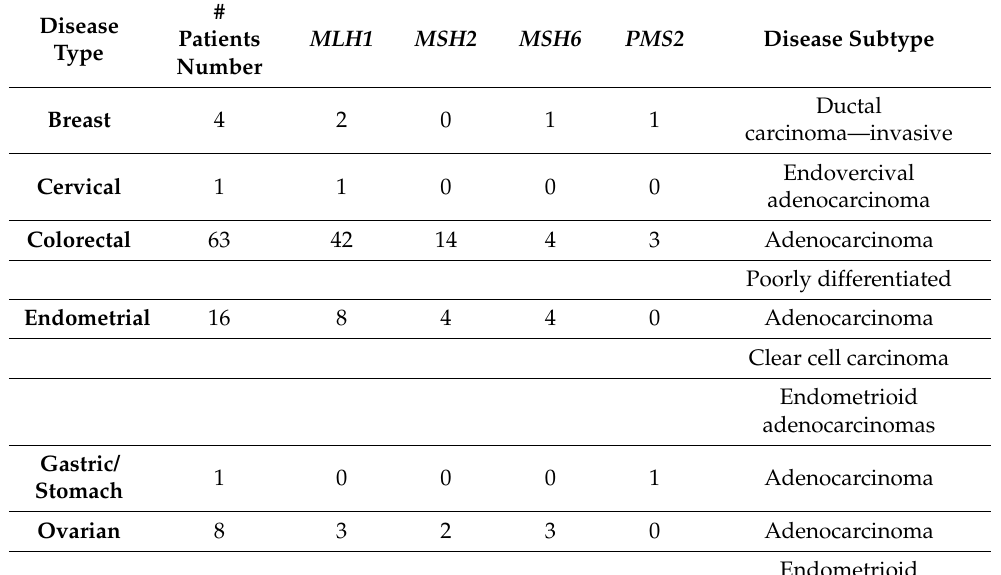
Table 5. Type of cancer and histological subtype in patients with pathogenic MMR variants and number of patients with variants by MMR gene.